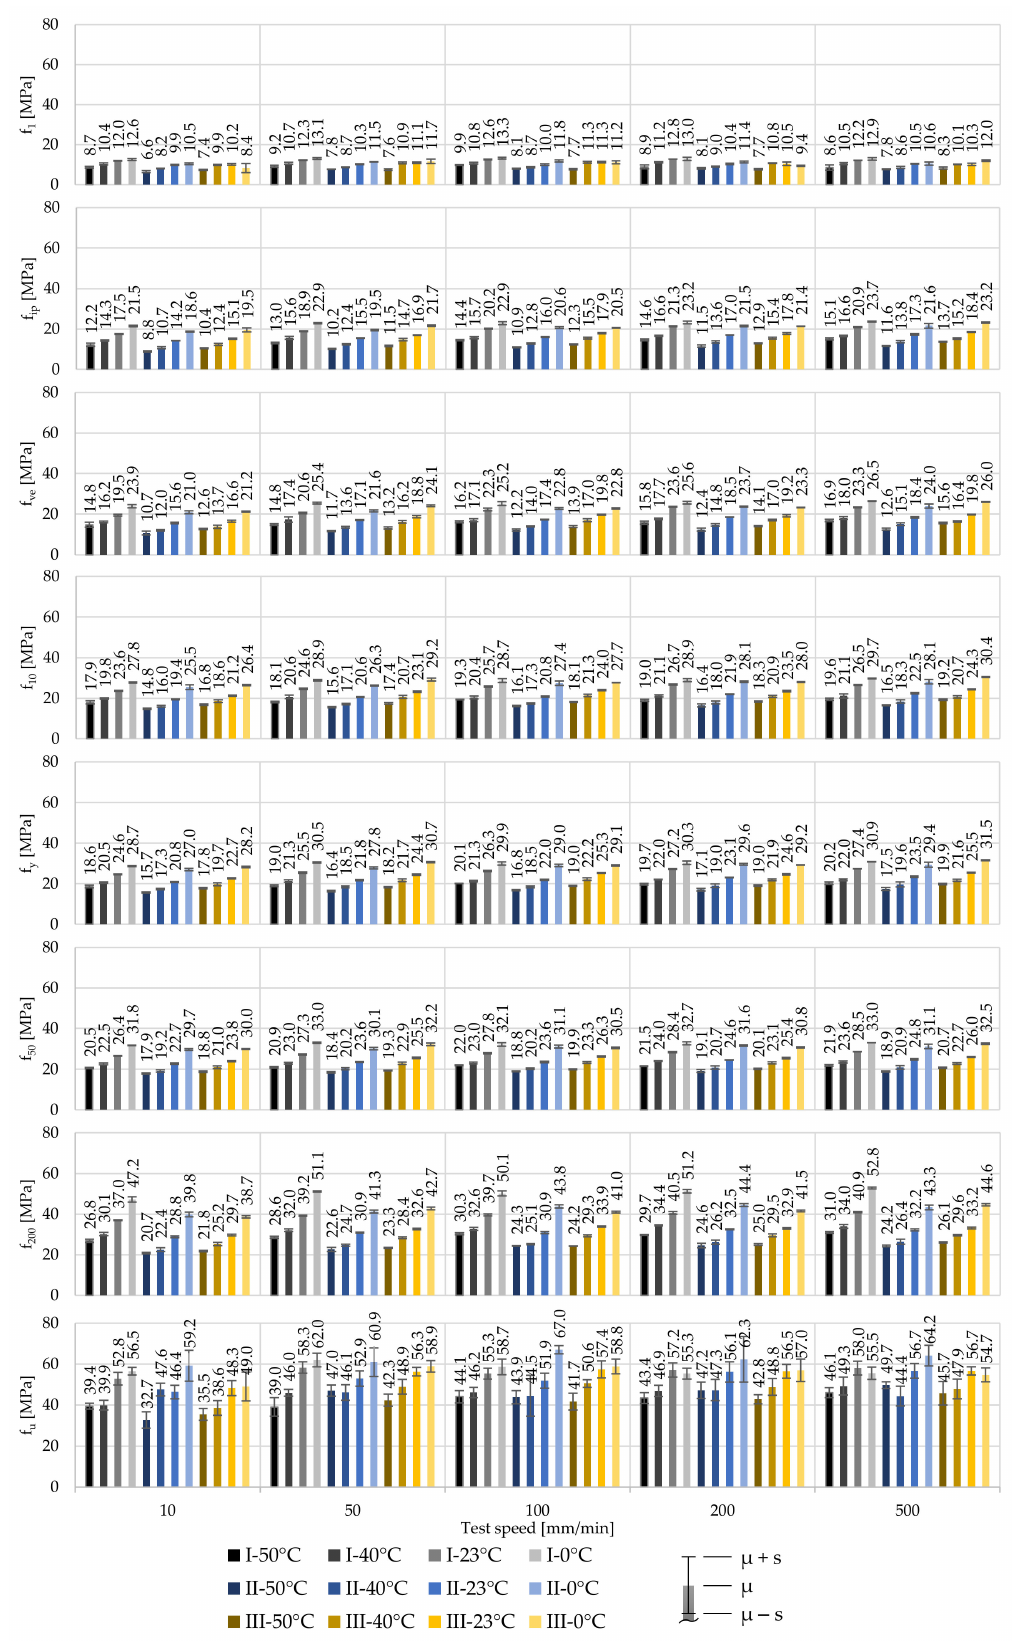
Figure 8. Influence of the test temperature and test speed on the stress at specific strains for 100 µ m ETFE foils of producers I, II, and